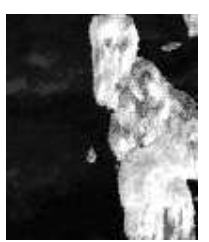
Figure 2. The ASTER image (Band 2) for spectral unmixing, at 42 ° 25’ 32’’N , 72 ° 16’ 39’’ W